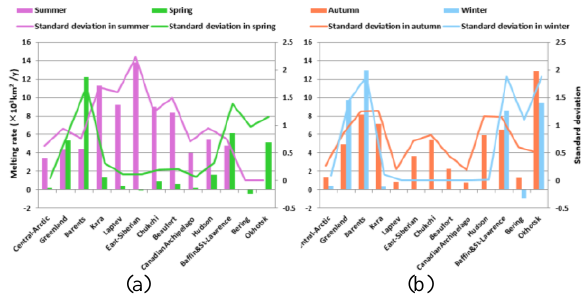
Figure 6. The melting rate and corresponding standard deviation of 13 regions in Arctic during (a) melting period and